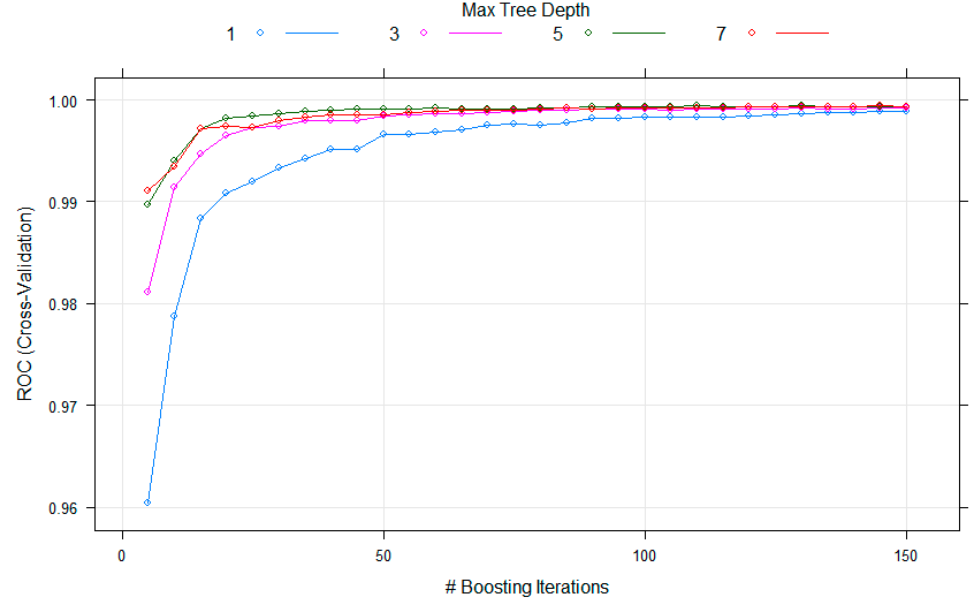
Figure 8. GBM model training process with the use of the stochastic gradient boosting algorithm. Source: own elaboration using R package.